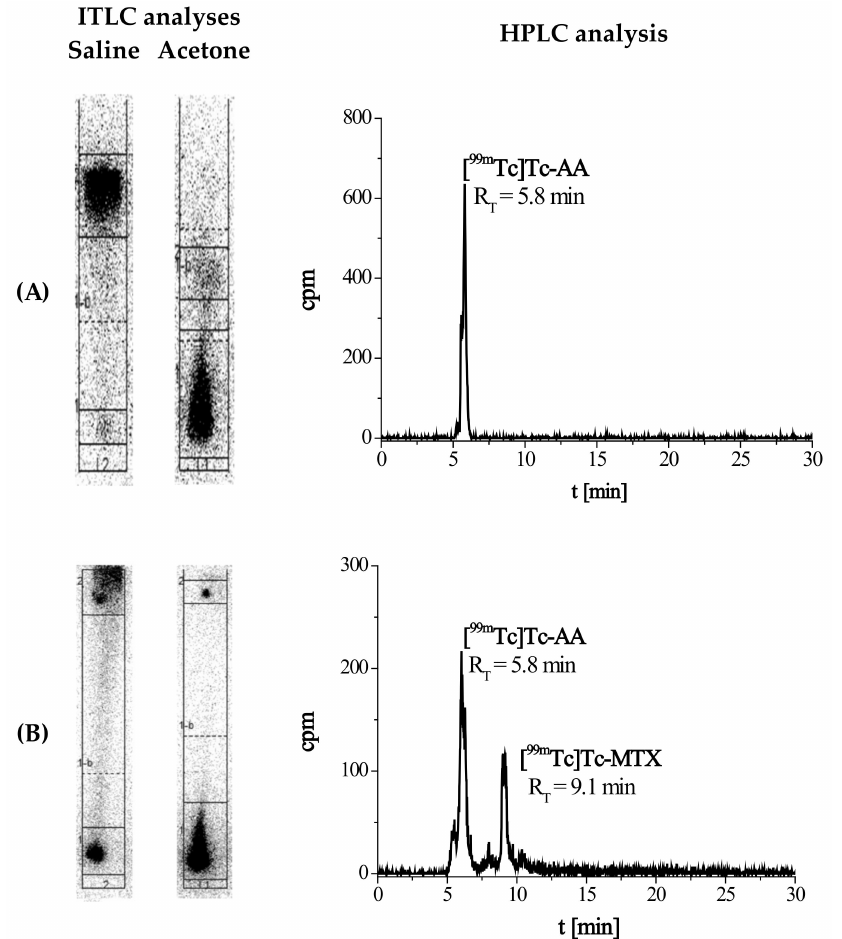
Figure 3. ITLC and HPLC analyses verifying formation of ( A ) intermediate [ 99m Tc]Tc-AA complex and ( B ) final [ 99m Tc]Tc-MTX complex. Basing on ITLC results, differentiation between final radio- complex and intermediate radiocomplex is impossible without specific aid in form of HPLC